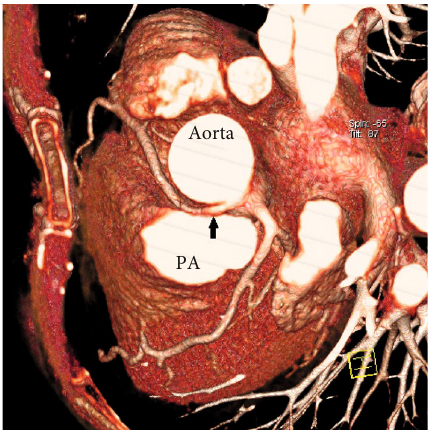
Figure 3: CT coronary angiography with volume-rendered 3D reconstruction of the images, revealing the interarterial course of the RCA (pointed with the arrow) between the aorta and the pulmonary artery